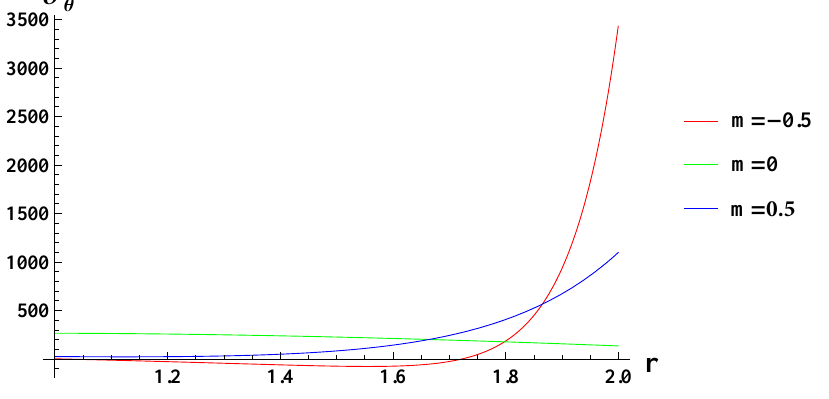
Figure 26. Tangential stress (in MPa) along the radius r (in cm) of the cylinder, under the effect of rotation ( ω 2 = 50 rad/s), external pressure p o = 50 MPa and quadratic volume